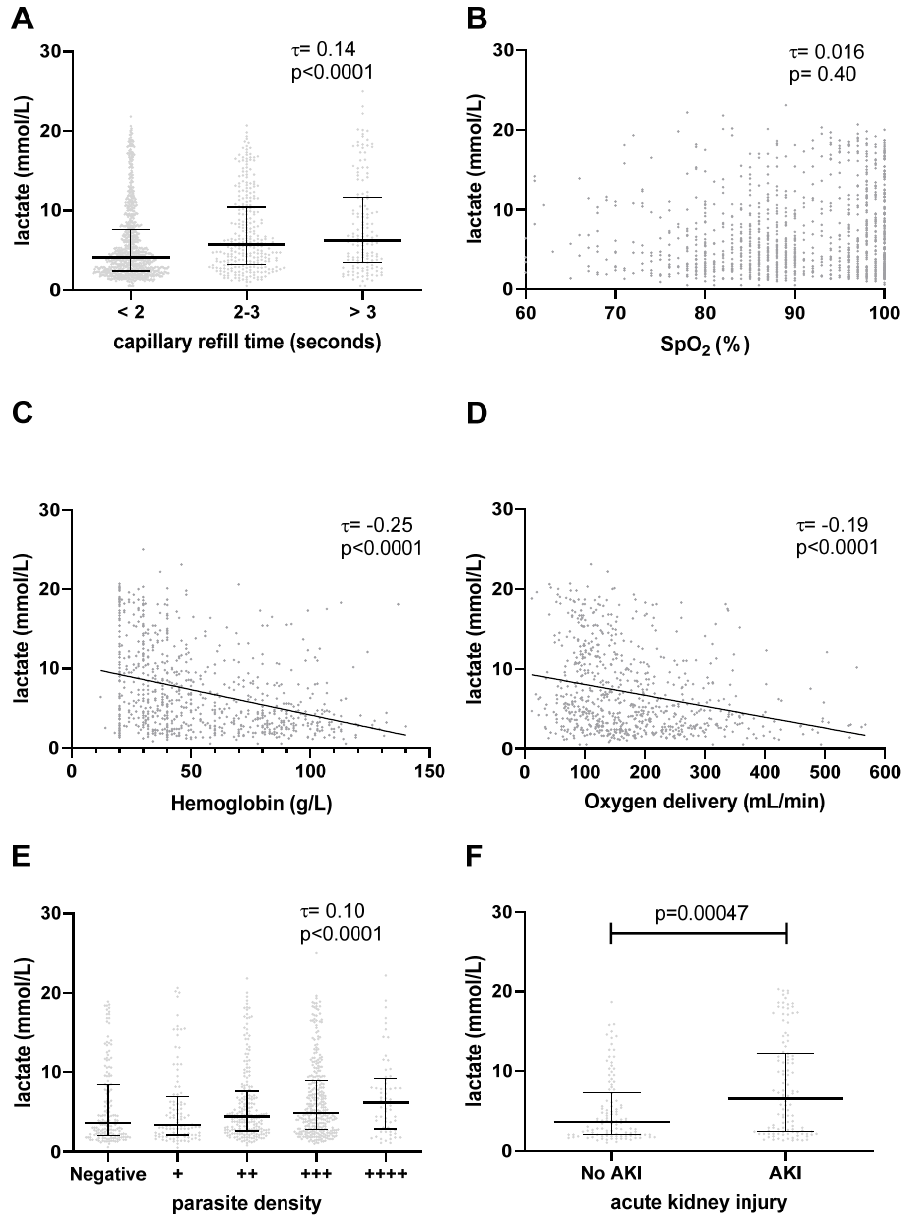
Figure 4. Mechanistic insights derived from the association of lactate with other clinical and laboratory variables. ( A ) Patients with prolonged capillary refill time had higher blood lactate concentrations than patients with normal capillary refill times. ( B ) Lactate was not correlated with oxygen saturation (SpO 2 ). ( C ) Hemoglobin concentration and ( D ) global oxygen delivery ( D O ) were inversely correlated 2 with lactate levels. ( E ) Higher circulating parasite densities were associated with higher lactate levels. ( F ) patients with AKI had significantly higher blood lactate concentrations than patients without AKI. Together, these data suggest that impaired tissue oxygenation (poor perfusion, low blood oxygen carrying capacity, and local hypoxia due to parasite sequestration) as well as impaired renal lactate clearance contribute to hyperlactatemia. Kendall’s tau ( τ ) was used to determine nonparametric rank correlation coefficients between